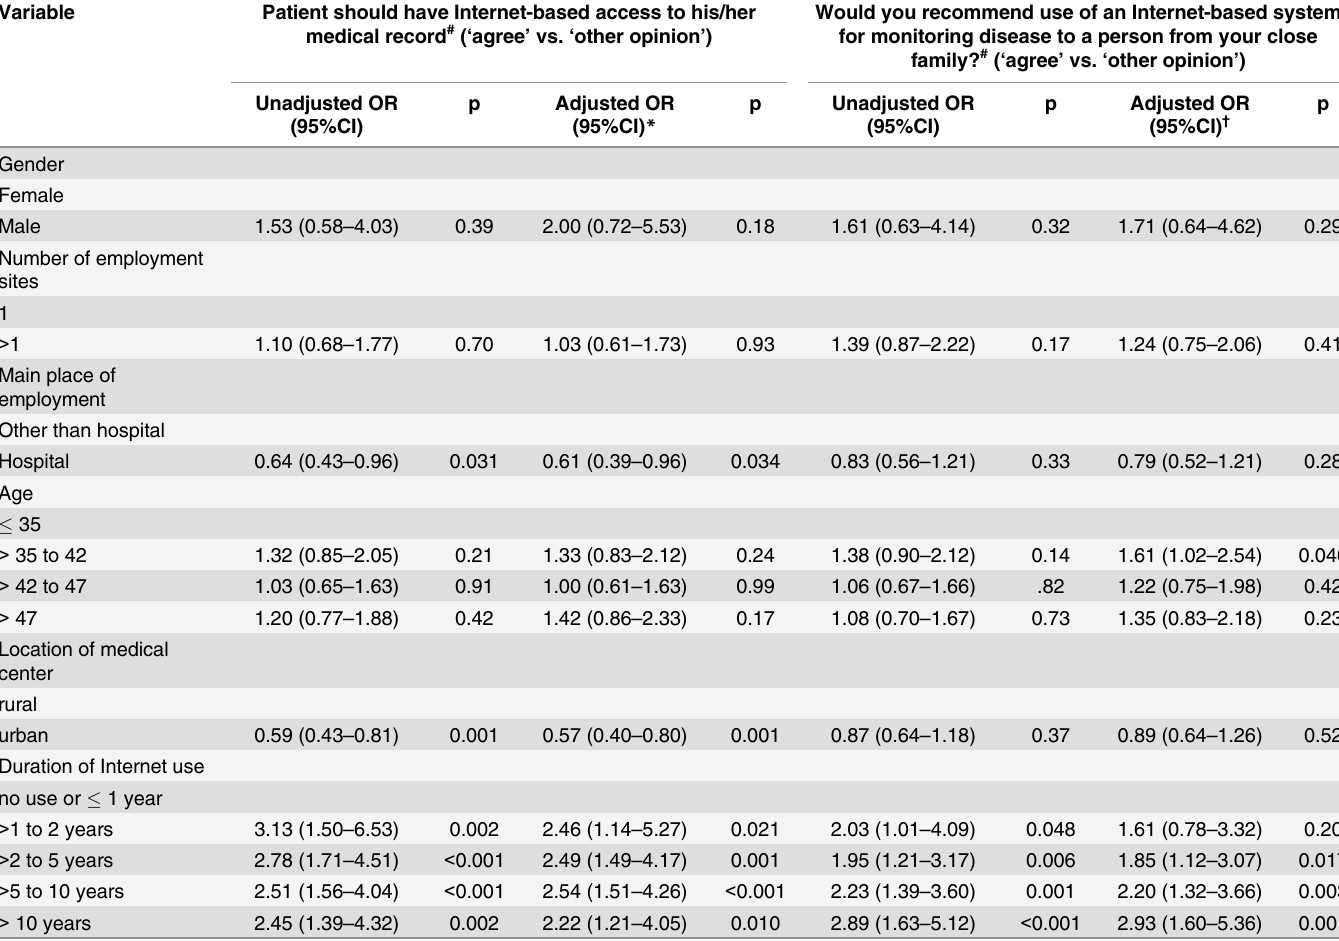
Table 5. The results of univariate and multivariate logistic regression modeling for acceptance of patient access to their Internet-based medical record and making recommending use of telemonitoring to family members with chronic disease.